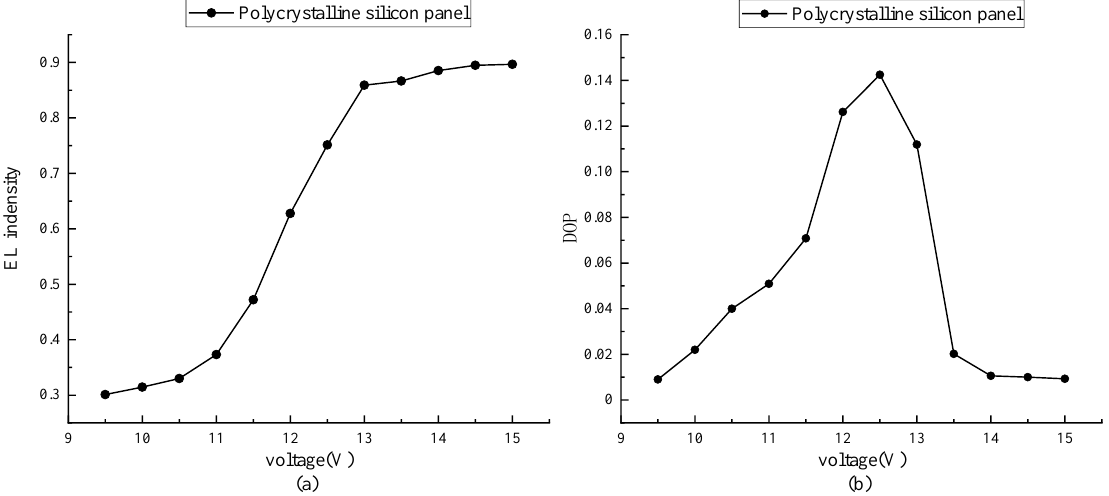
Figure 10. Diagram of polycrystalline silicon photovoltaic panel ( a ) electroluminescence intensity of the photovoltaic panel with the forward bias voltage; ( b ) degree of polarization of the photovoltaic panel with the forward bias voltage.